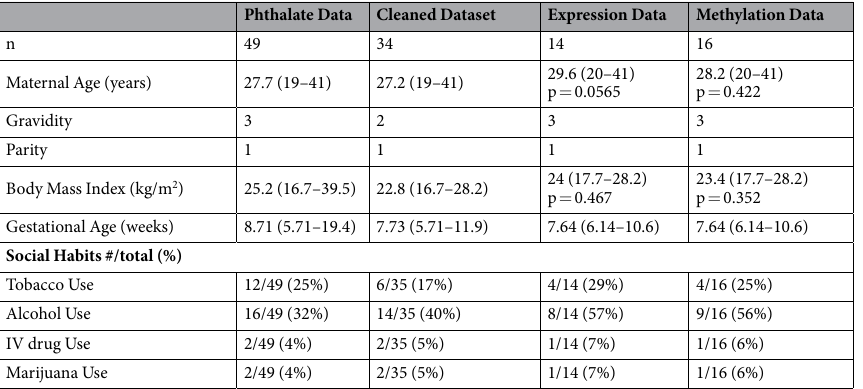
Table 1. Demographic characteristics of participants. All values are listed as mean (range) unless otherwise specified. ANOVA was performed to assess statistically significant differences as compared to the phthalate data